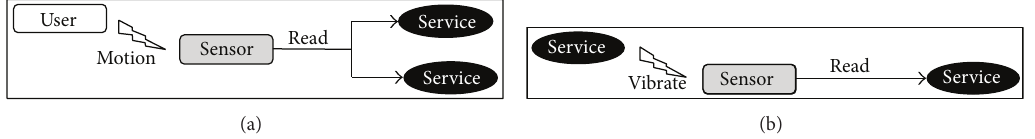
Figure 3: (a) Normal model of reading sensor signals caused by user actions. (b) Exploiting the vibration function to modulate sensor signals and establish a covert channel.